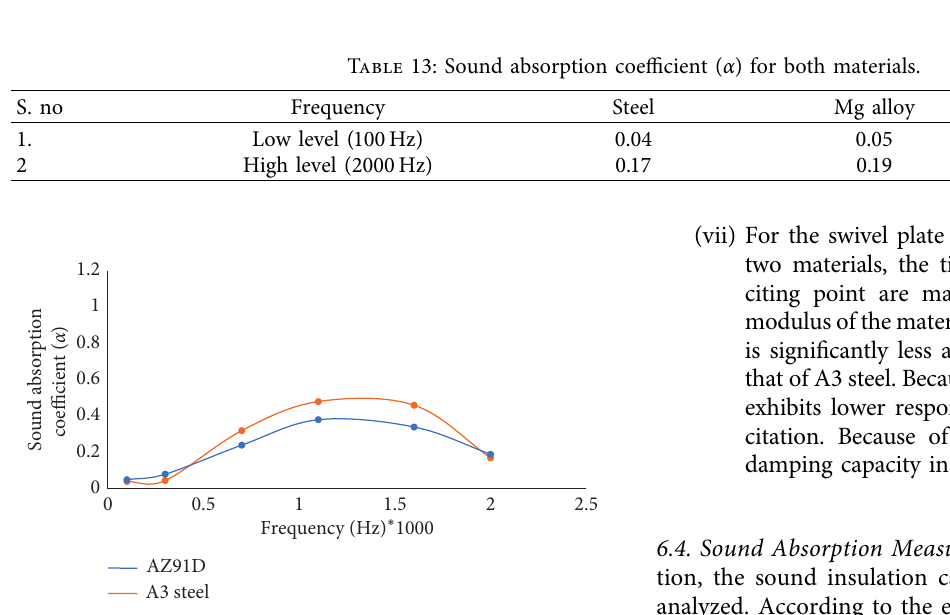
Figure 15: Sound absorption coefficient ( α ) vs. frequency (Hz) for both materials.